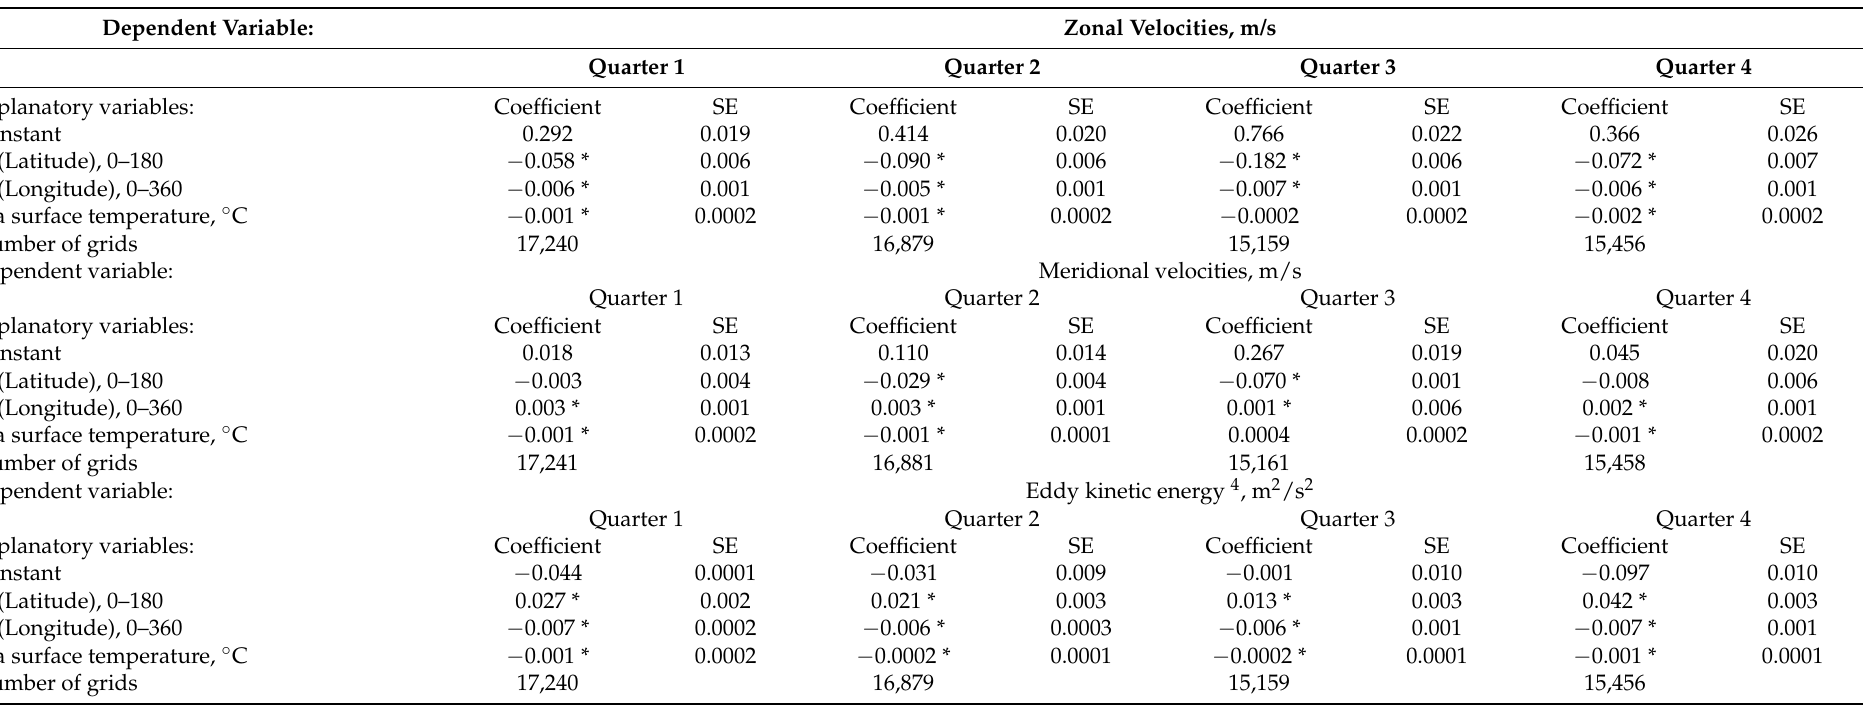
Table 8. Efficient estimates of static random effects models using quarterly data for 2000–2019 for 1 × 1 degree grids on zonal and meridional ocean surface current velocities and eddy kinetic energy in the Southern hemisphere explained by geodesic variables, time indicators for the years, and sea surface temperatures 1,2,3